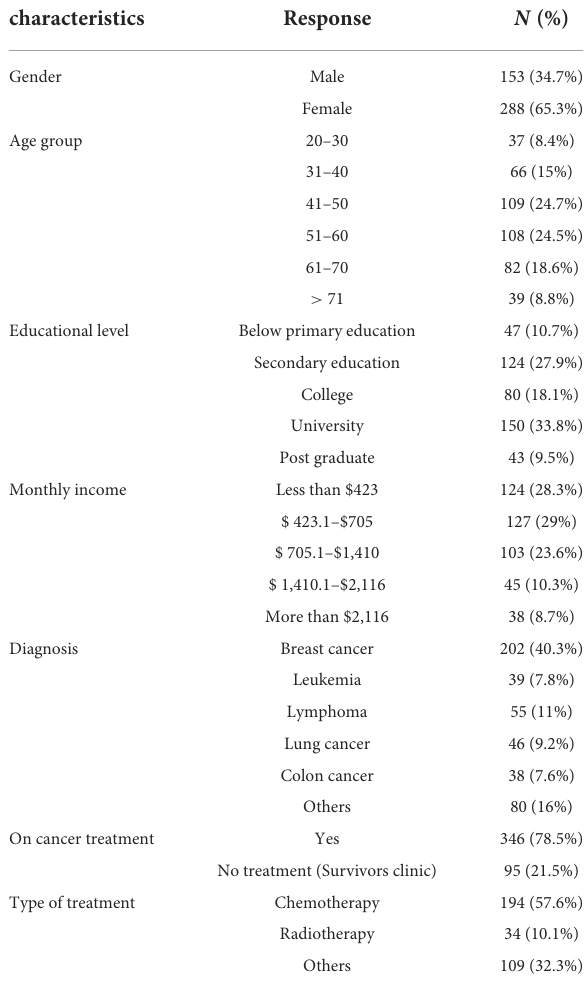
TABLE 1 The demographic characteristics of the